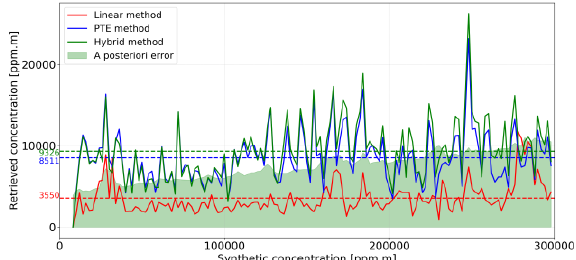
Figure 10 . Standard deviations according to the synthetic plume concentration for semi-synthetic case. The a posteriori uncertainty is plotted for the same concentration.